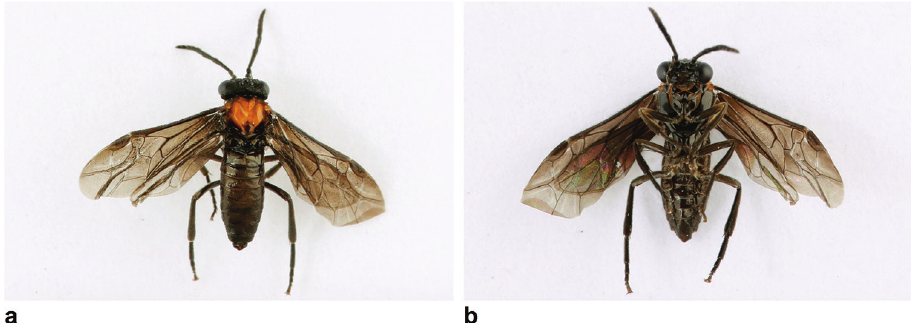
Figure 14. Waldheimia sp. A, male (P4237.B), body length 5.5 mm. a Dorsal view b ventral view.